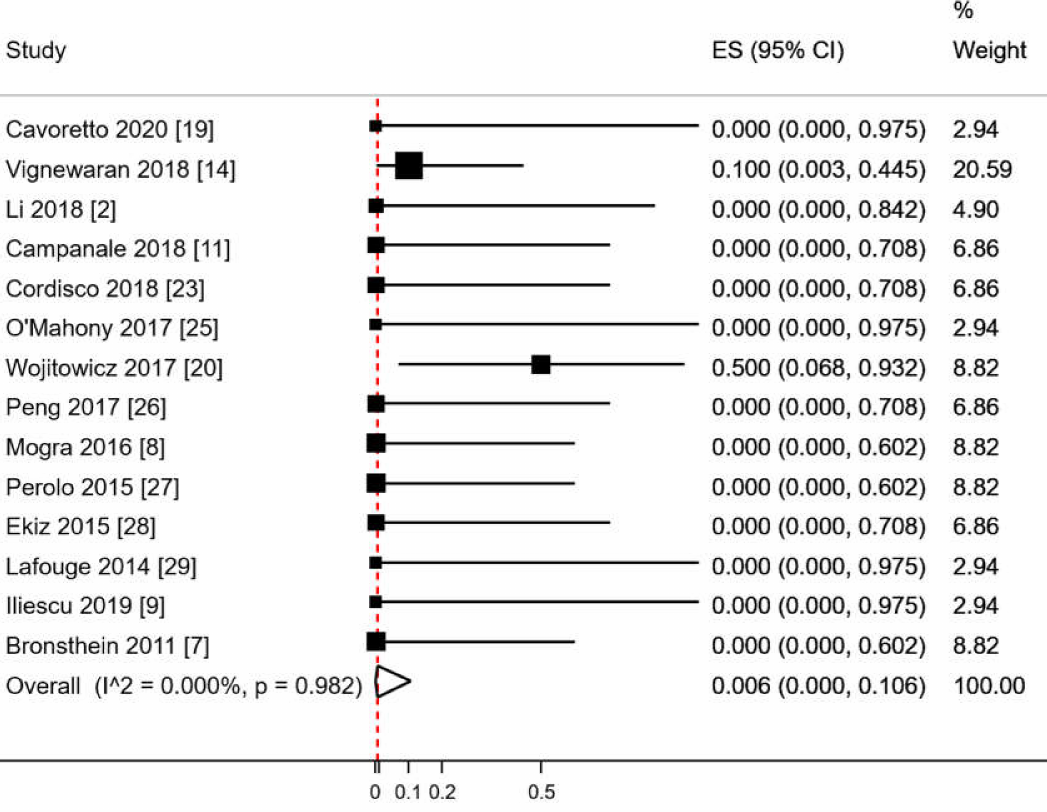
Figure 3. Pooled proportion of chromosomal anomalies in RAA / RDA fetuses who underwent karyotyping. ES: e ff ect size. CI: confidence interval. Red dashed line describes the e ff ect estimate found in the present analysis. Iˆ2: I 2 of